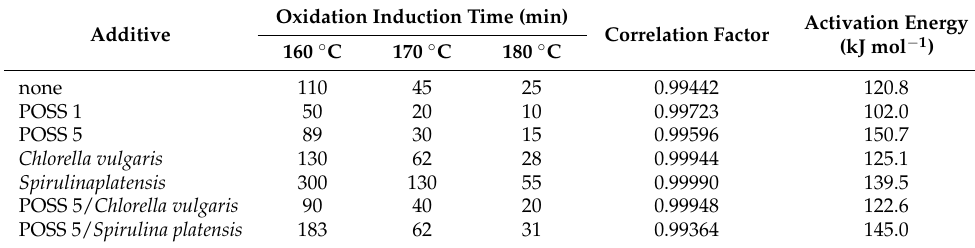
Table 1. Activation energies of thermal oxidation of unirradiated EPDM-based